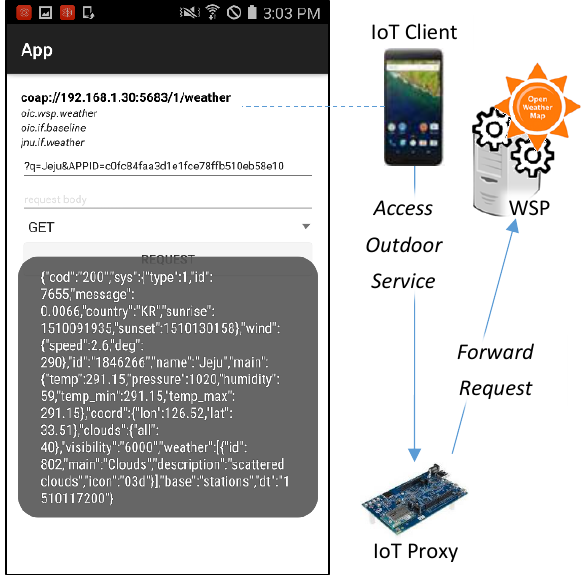
Figure 15. Fragment of RAML definition for registering WSP.